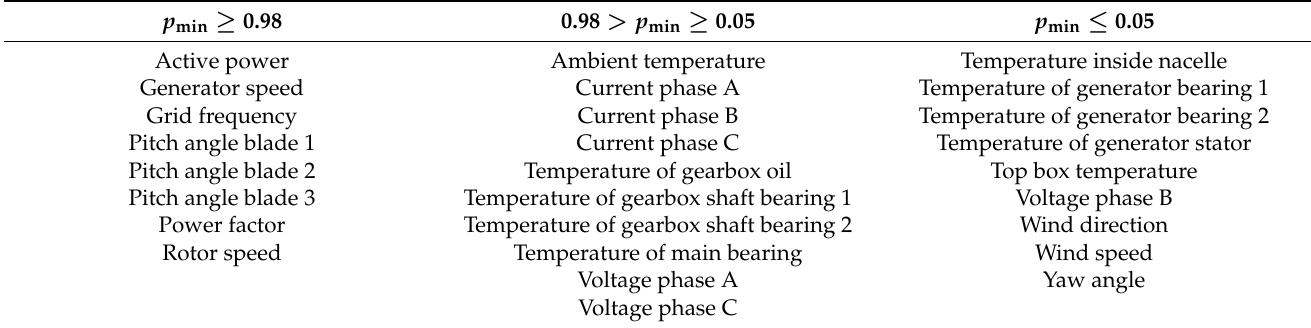
Table 3. Signals sorted into bins of p min . Here, p min is the minimal p -value of a signal for all aggregation resolutions and turbines as already carried out in Figure 3. p min ≥